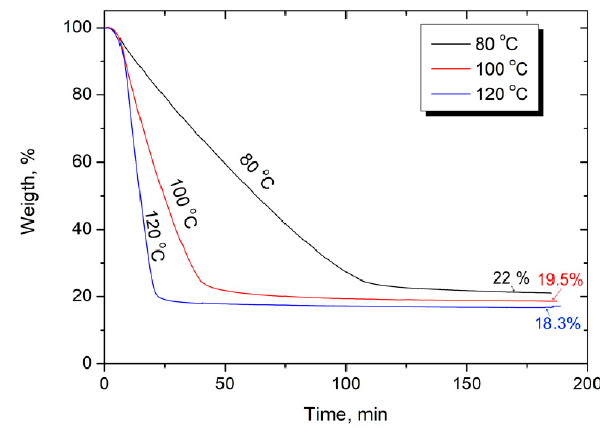
/ N-methyl-2-pyrrolidone